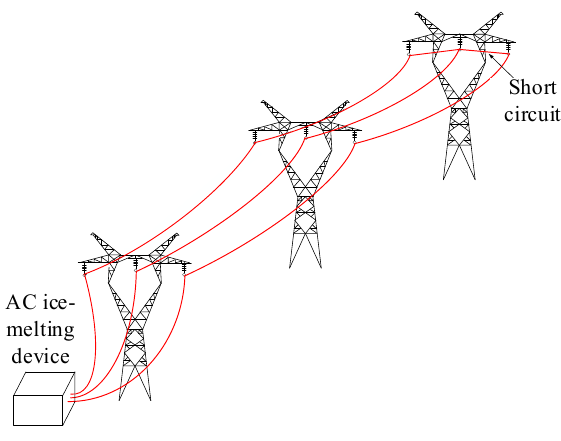
Figure 4. Three phases short-circuit ice melting diagram.